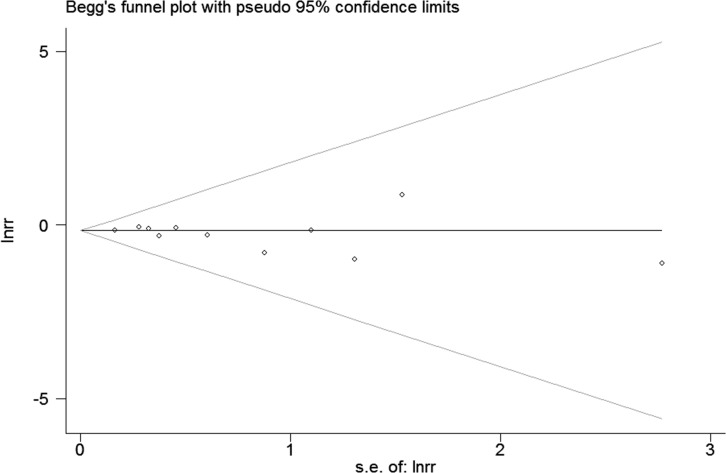
Begg's Funnel plot.